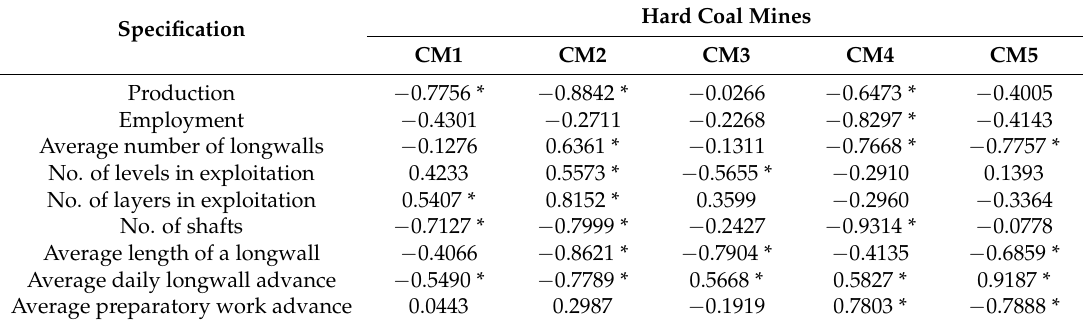
Table 1. Correlation coefficients for total production costs in examined hard coalmines over the period